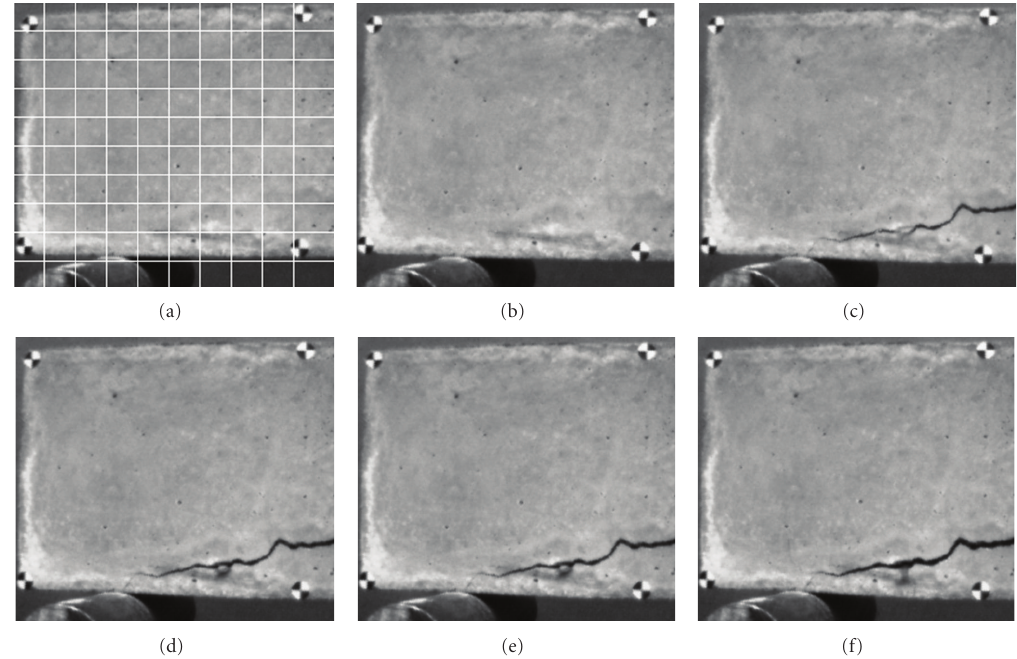
Figure 10: Concrete surface at di ff erent acquisition times: (a) at 0 second (the first frame with dividing grids of the image domain); (b) at 0.625 second (the 26th frame); (c) at 0.65 second (the 27th frame at which the first crack appeared); (d) at 0.80 second (the 33rd frame); (e) at 1.20 seconds (the 45th frame); (f) at 1.85 second (the 70th frame). In (a), the 10 × 10 subdivisions for the image domain are overlaid with the image.